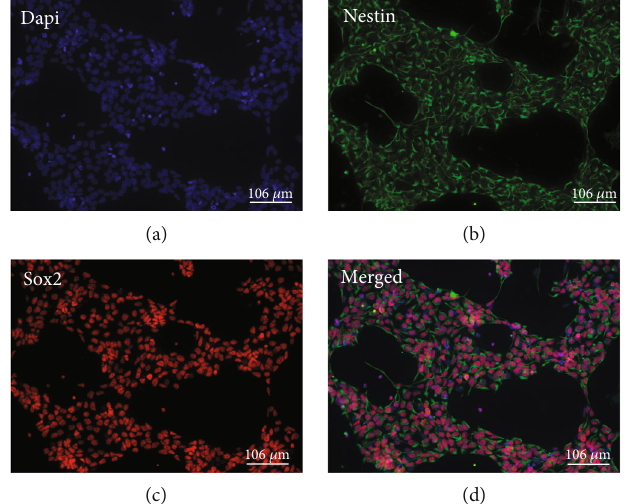
Figure 3: Human neural stem cells di ff erentiated from H9 cells express Sox2 (red) and Nestin (green) proteins. These cells are shown to have progenitor potential. Nuclei stained with DAPI are shown in blue. Scale bar = 106 μ m